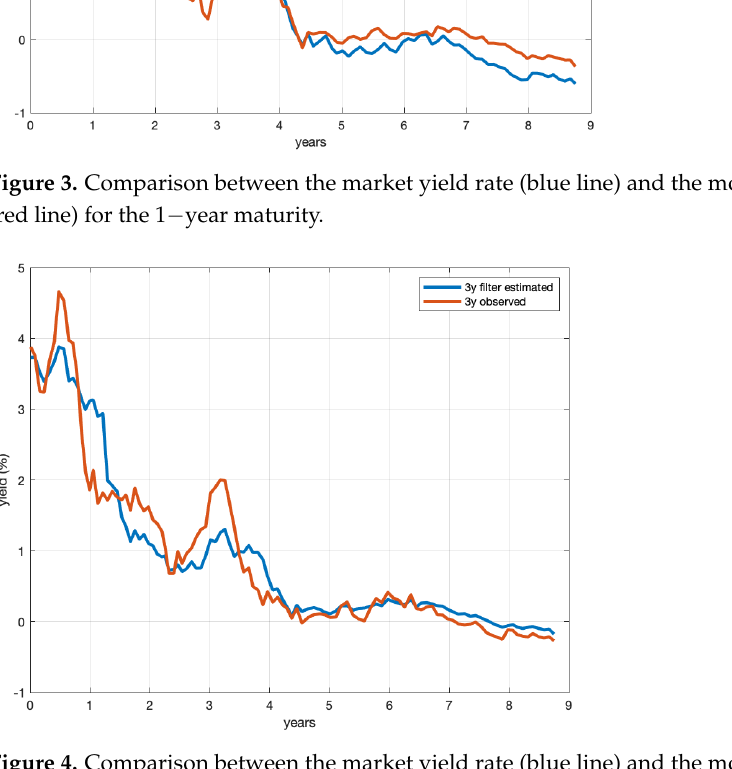
Figure 4. Comparison between the market yield rate (blue line) and the model − implied yield rate (red line) for the 3 − year maturity.